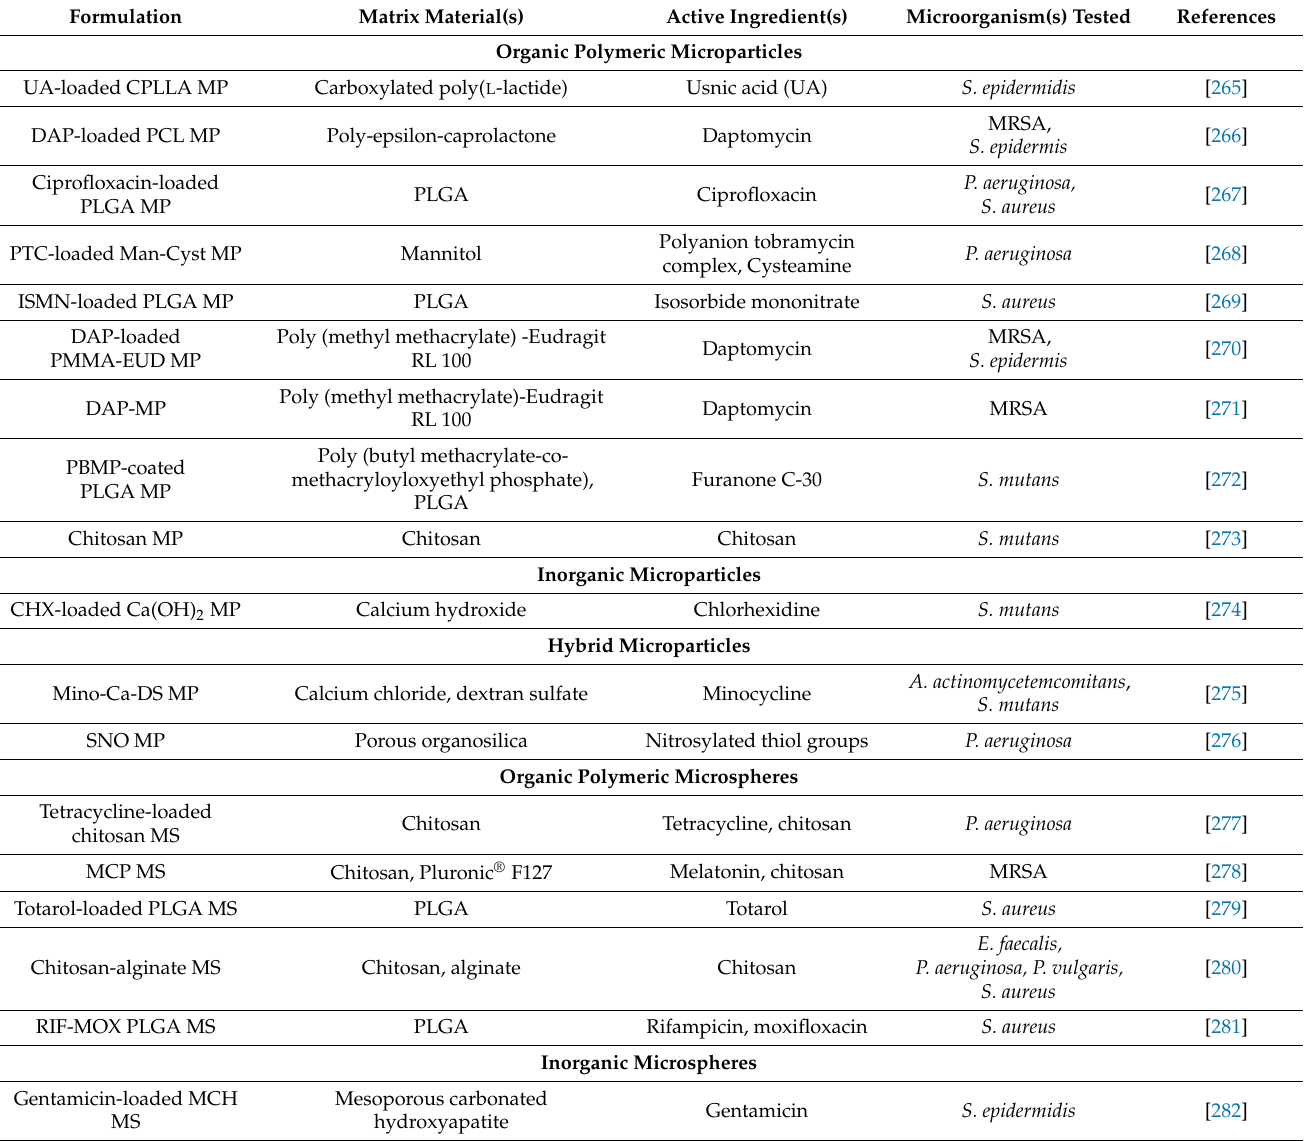
Table 4. Summary of studies on microparticles with antibiofilm